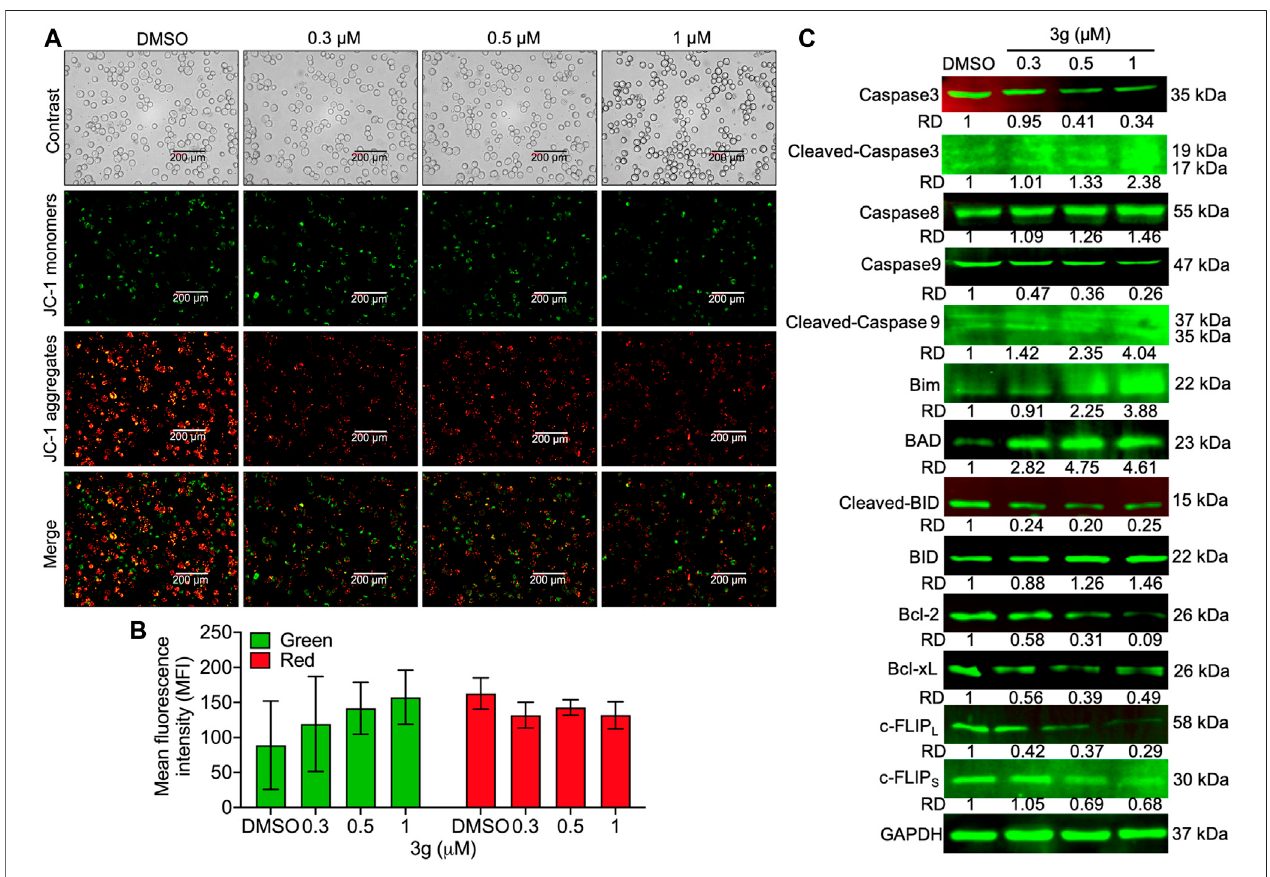
FIGURE 4 | Mitochondrial damage after 3g treatment in K562 cells. (A) Photomicrograph of JC-1 monomers and aggregates after 3g incubation at 24 h. (B) Quanti fi cation of the red/green levels showing extent of mitochondrial damage. (C) Protein expression levels of indicated proteins at 48 h of 3g